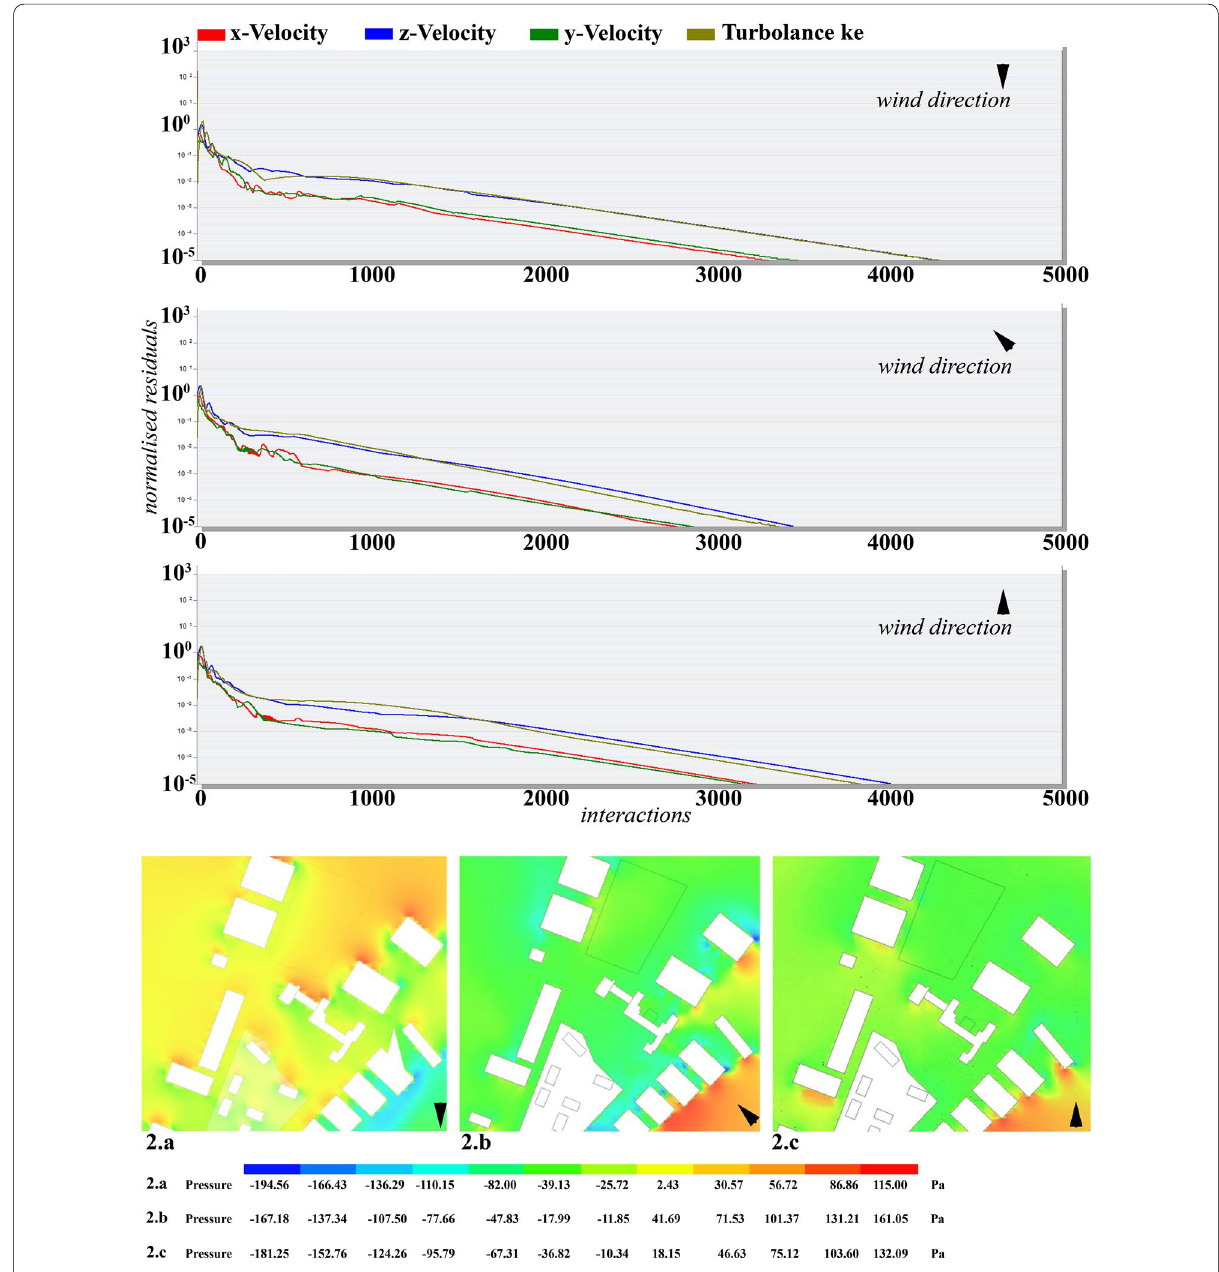
Fig. 8 Case no. 2: table of convergence and pressure map